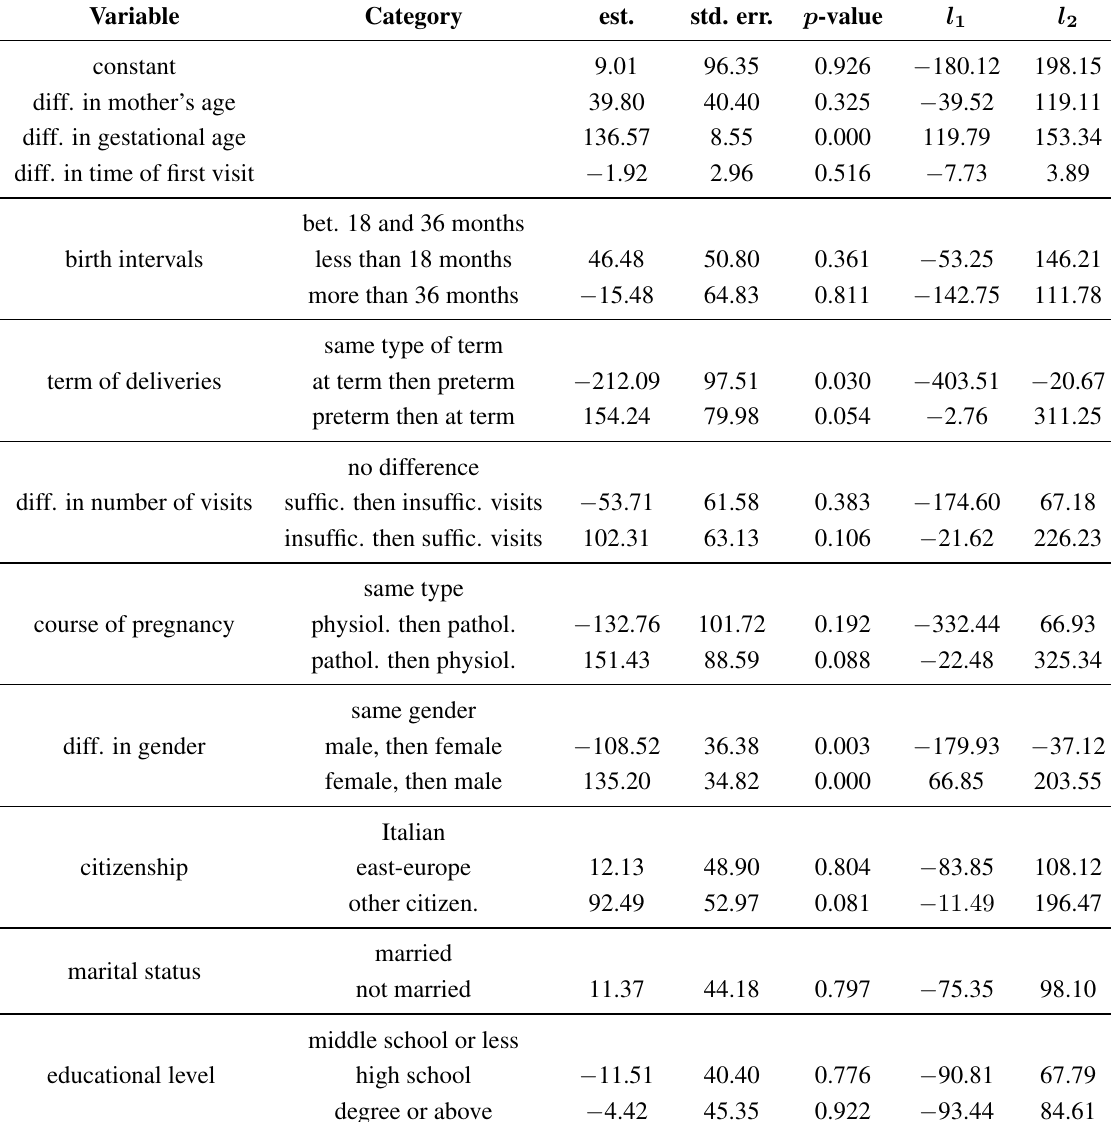
Table 5. Linear regression results for the differences in birthweight: all covariates (adjusted R 2 =